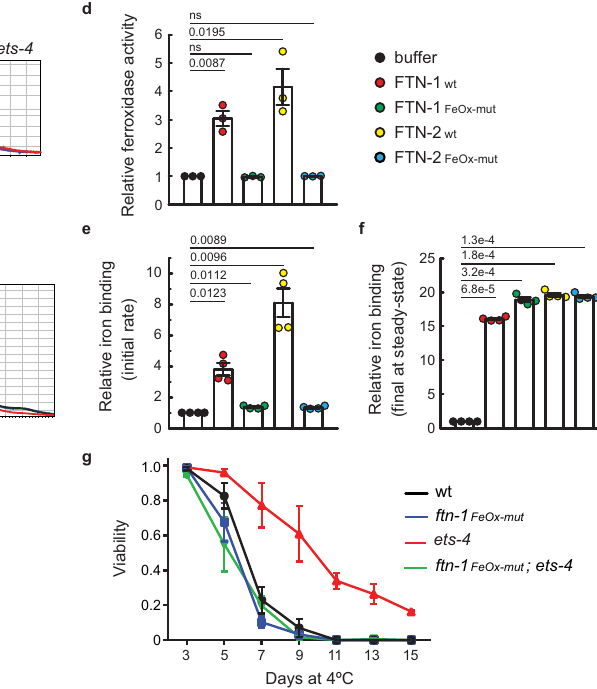
ferrous ammonium sulfate (FAS) relative to buffer (no FTN). n =3 independent experiments. e TheFeOX-mutmutationsreducetheinitialvelocityofironbinding. TheinitialrateofironbindingaftermixingFASwithrecombinantFTNs,asin d ,was measured relative to buffer. n =4 independent experiments. f The FeOX-mut mutations do not impact a steady-state iron binding. Recombinant FTNs, as in d , were incubated with FAS for 1h. The amount of soluble (FTN-bound) iron was measured relative to the buffer. n =4 independent experiments. g The FeOx-mut mutations in ftn-1 abolish increased cold resistance of ets-4 mutants. Cold survival of wt, ftn-1(FeOx-mut) , ets-4(rrr16) and ftn-1(FeOx-mut) ; ets-4(rrr16) animals was determined as in Fig. 1a. ( FeOx-mut indicates the ftn-1 ( syb2550 ) allele). n =3 inde- pendent experiments. 261 – 396 animals scored per time point. Statistical analysis: Error bars: SEM; p values calculated using unpaired two-sided t -test (in a , b ) or paired one-sided t -test (in d – f ); ns not signi fi cant. Source data are provided as a Source Data fi